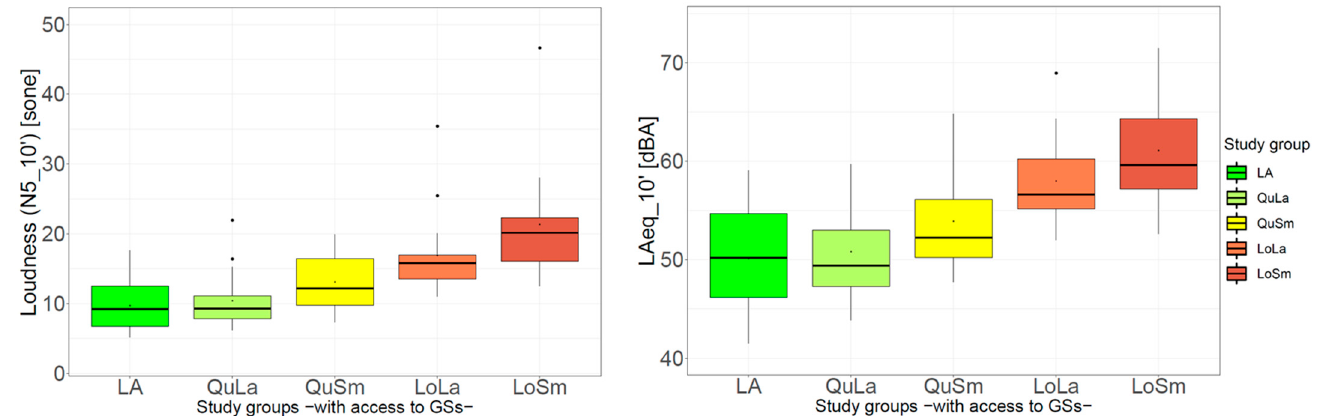
Figure 6. Boxplots of the psychoacoustic and acoustic parameters among different study groups: ( left ) loudness- N5 _ 10 ′ ; ( right ) L Aeq_10 ′ . Study groups “Low noise exposure at home with No Access to GSs (LNA)” and “High noise exposure at home with No Access to GSs (HNA)” are not shown as these have no access to any green spaces. Note the different scales of loudness and L Aeq_10 ′ .